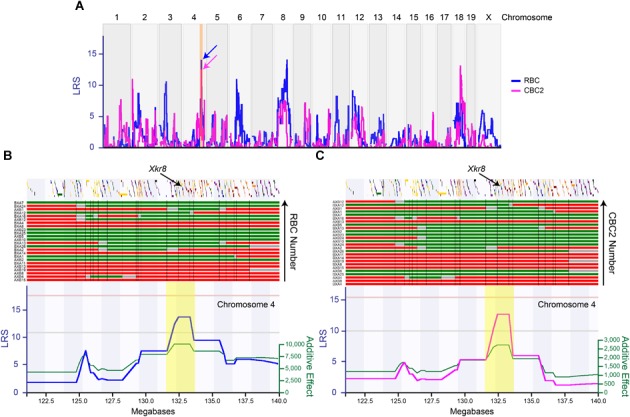
The variation in RBC number (blue trace) and CBC2 number (magenta trace) each mapped to multiple genomic loci (A), including one shared locus on Chr 4 (arrows in A). The expanded map of a distal portion of Chr 4 (120–140 Mb, highlighted in orange in A) is shown below (in B,C), with the LRS plots now shown separately for each cell type, with RBCs on the left (B) and CBC2s on the right (C). The position of all genes is indicated across the top, along with the B6/J versus A/J haplotypes across the RI strains (red and green bars, respectively, ordered from bottom to top according to cell number in ascending order). In addition, the additive effect of each A allele (green trace) is shown beneath each LRS trace. The interval interrogated at the Chr 4 locus extended from 131.5 to 133.5 Mb (highlighted in yellow in B,C), and encompassed 55 genes. Gray regions indicate undetermined haplotype blocks. The position of Xkr8 is indicated, at 132.85 Mb. Horizontal pink and gray lines in both (B,C) indicate the significant and suggestive LRS thresholds determined by permutation testing.